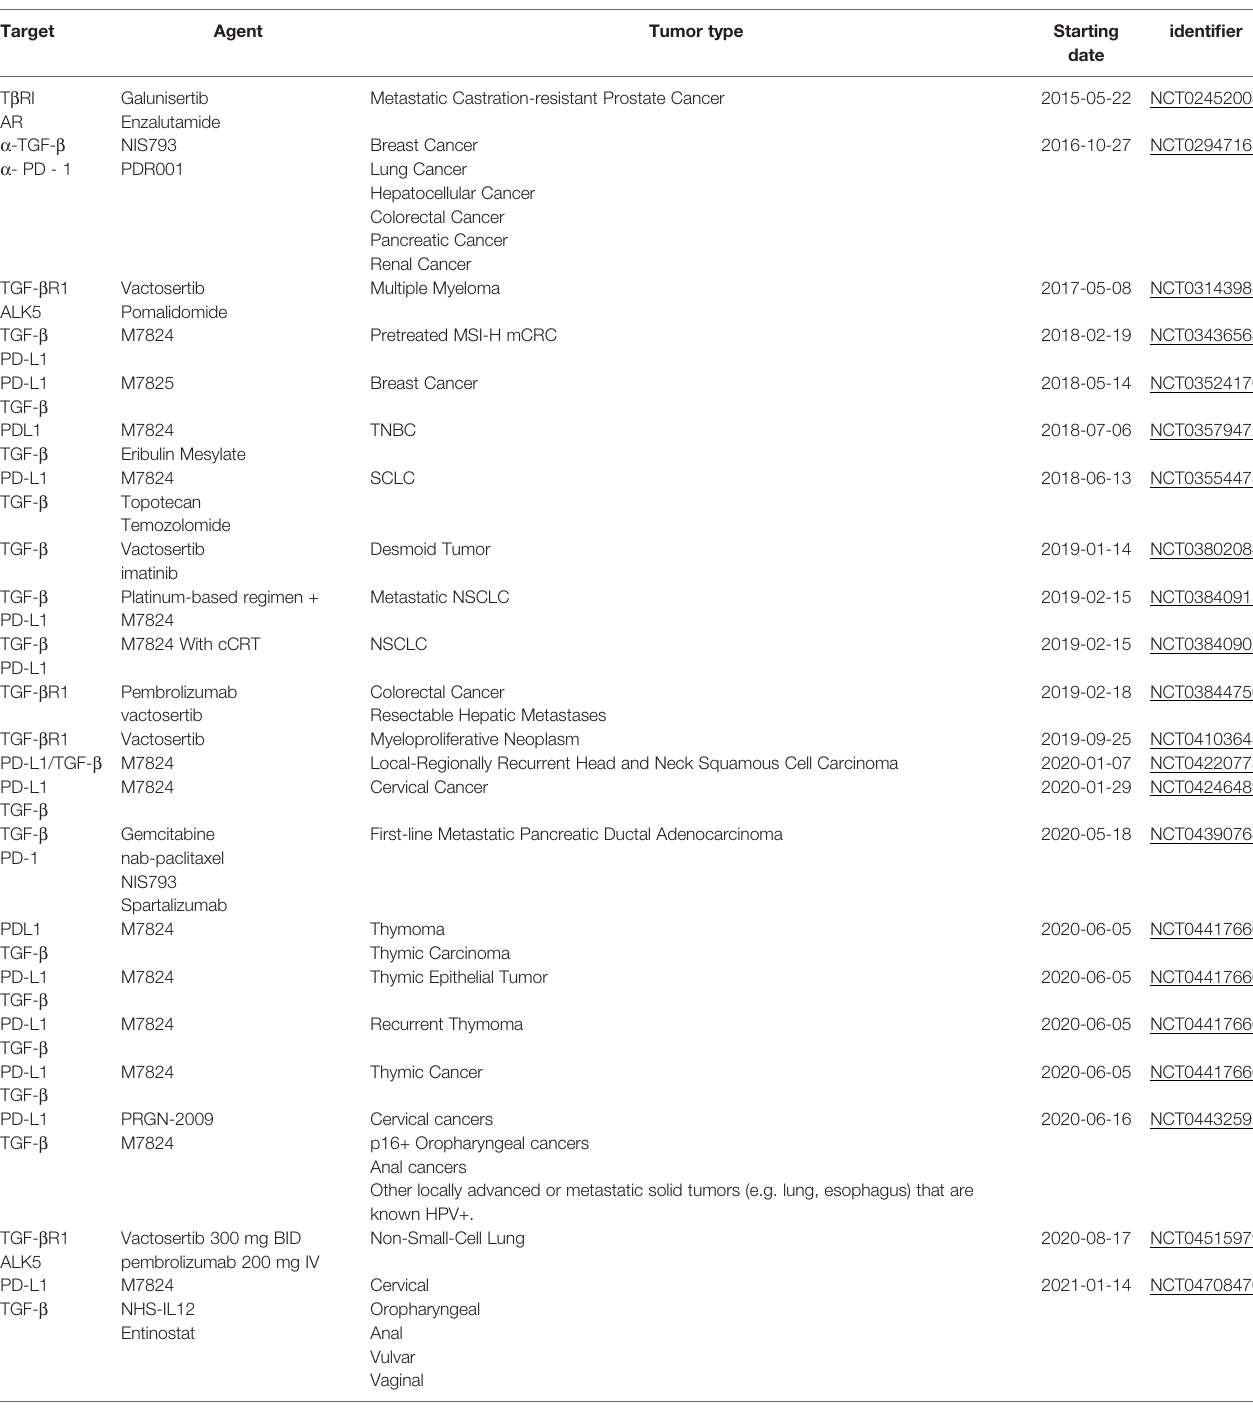
TABLE 2 | Ongoing clinical trials to evaluate TGF- b pathway